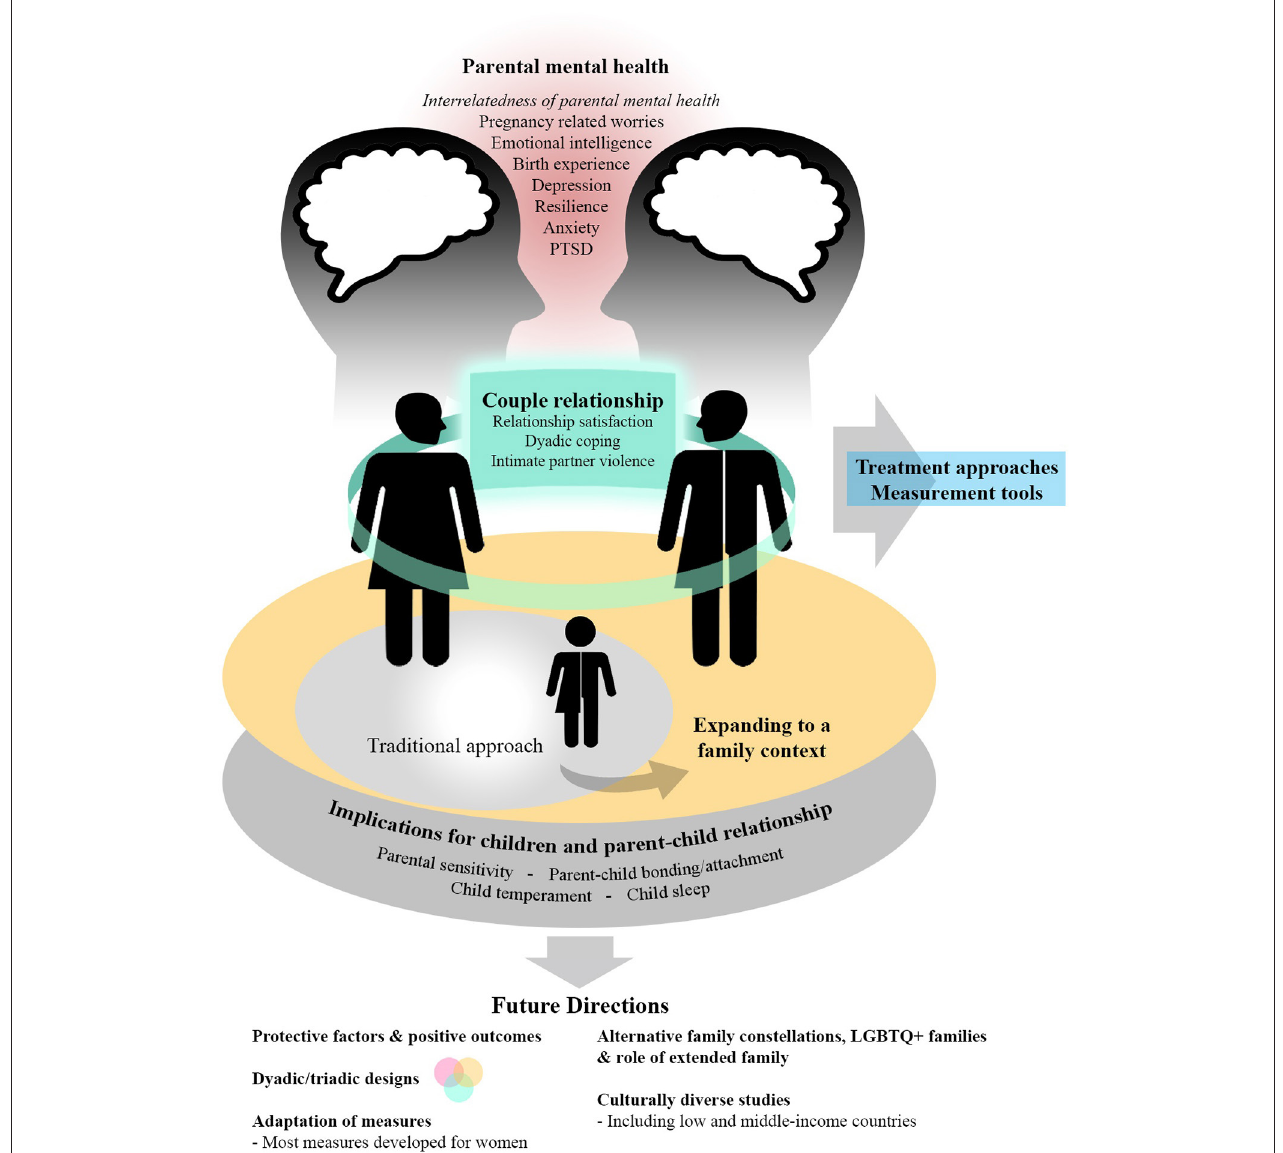
FIGURE 1 | An integrative depiction of themes covered in this Research Topic including future